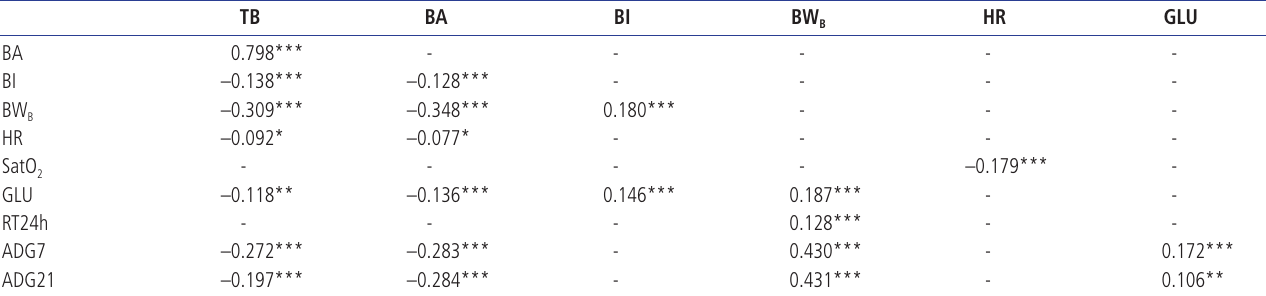
Table 5. Pearson’s correlations among the most significant potential predictor measured during farrowing and soon after birth and average daily gain (ADG) of the piglets from birth until 7 and 21 days of age